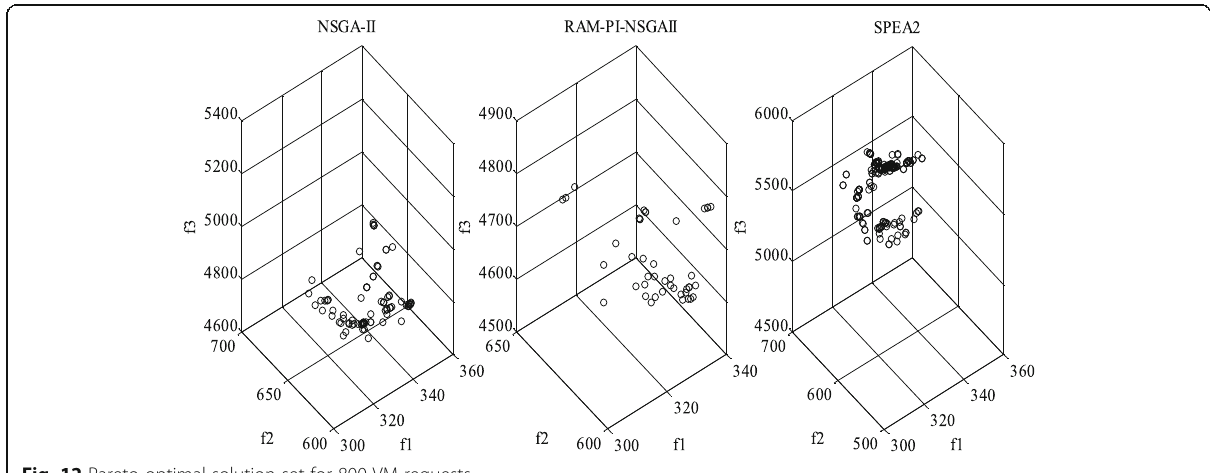
Fig. 12 Pareto optimal solution set for 800 VM requests